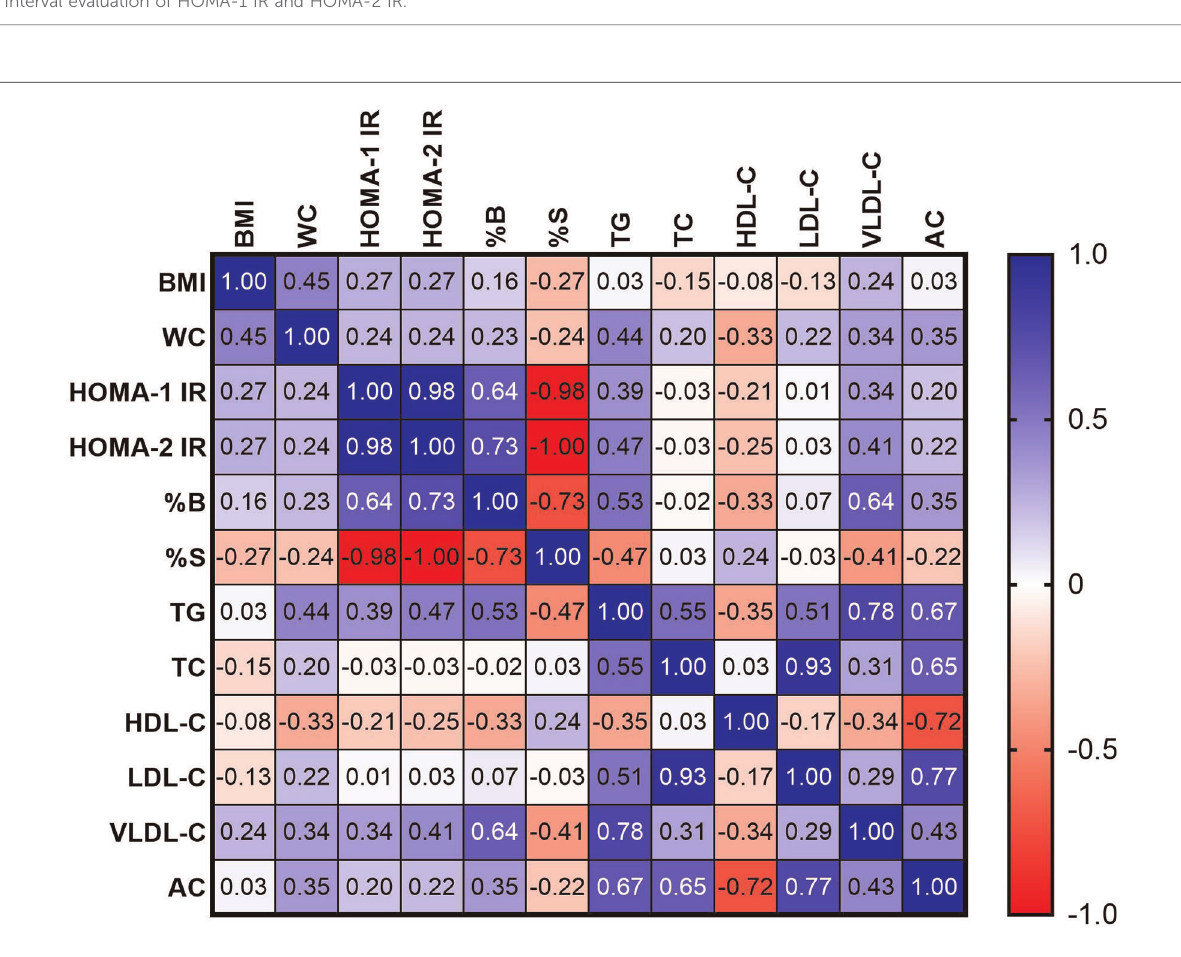
FIGURE 2 Heat map correlation between parameters of insulin resistance and parameters of lipid pro fi